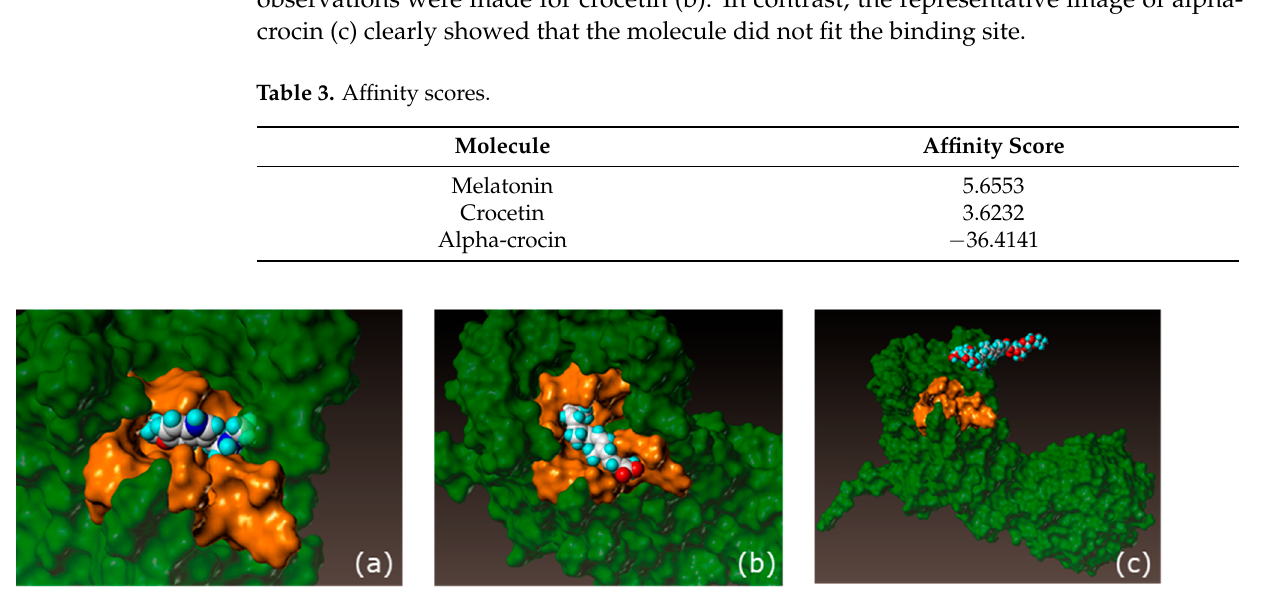
Figure 9. Representative images of melatonin ( a ), crocetin ( b ), and crocin ( c ) from the analysis of docking to the receptor MT1R. The green area represents the MT1 receptor surface, and the gold area represents the binding site of melatonin on the MT1 receptor. Carbon atoms are in white, oxygen atoms are in red, nitrogen in blue, halogens are in light blue (cyan).